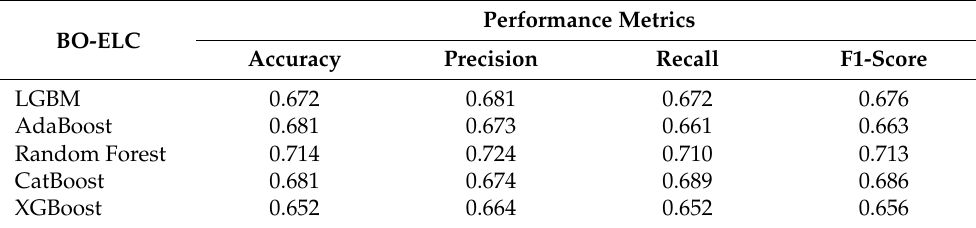
Table 3. Performance measures of BO-ELCs.